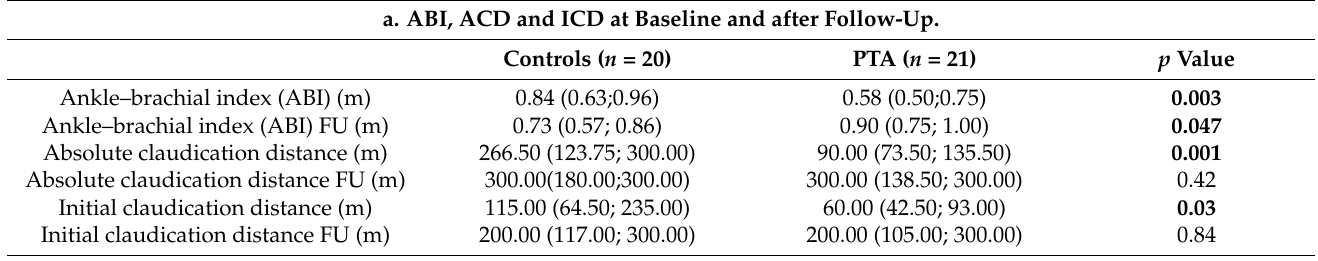
Table 4. ABI, ACD and ICD at Baseline and after Follow-up in the PTA and Control Group. a. ABI, ACD and ICD at Baseline and after